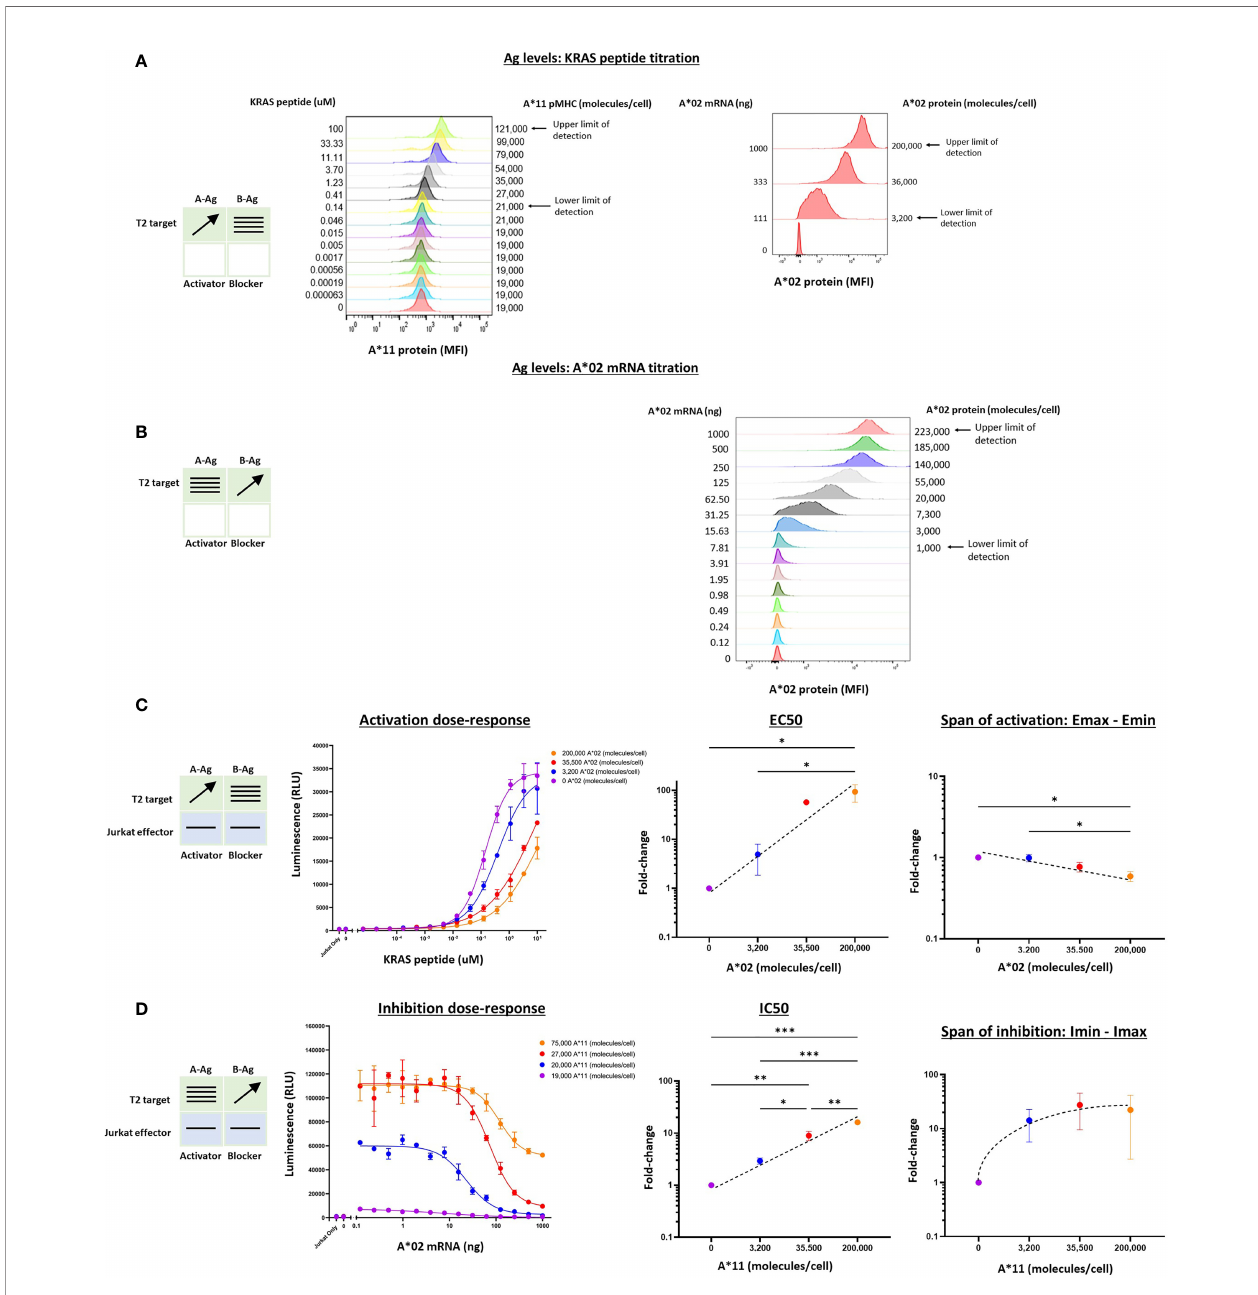
FIGURE 3 | Two-dimensional target Ag/peptide titration (KRAS pMHC and A*02) in T2 [A*11(+)A*02(-)] target cells. 50 m M NY-ESO-1 peptide was added to all cultures to ensure surface expression of A*02 pMHC molecules in T2 cells that are de fi cient in peptide display (see Methods ). (A) KRAS peptide titrated with A*02 mRNA held constant. A*11 staining is shown as a proxy for KRAS peptide bound to A*11. KRAS peptide titration does not affect A*02 expression. (B) A*02 titrated with constant KRAS peptide concentration. A*02 standard curve for mRNA titration in T2 cells are in Supplementary Figure 2 . The effect of A*02 expression on KRAS/A*11 pMHC level (the equivalent of the left panel in Figure 2B ) was impossible to determine because an A*11-speci fi c antibody compatible with QIFIKIT was not available. (C) Dose-response to KRAS and A*02 target Ag variation with constant activator/blocker ratio on effector cells. EC50 and Emax vs. B-Ag levels. For curves that did not plateau, the maximum value of the fi tted curve was used as the Emax value, an underestimate. (D) IC50 and Imax vs. A-Ag levels. Note that EC50 and Emax are underestimated for the two highest A*02 levels due to saturation of the assay. A*11 molecules/cells was used as a proxy for KRAS peptide- loaded A*11 molecules and derived from part (A) . Dashed lines are meant to convey trends and are not fi t mathematically. *p<0.05, **p < 0.01, ***p < 0.001, ****p < 0.0001, n =